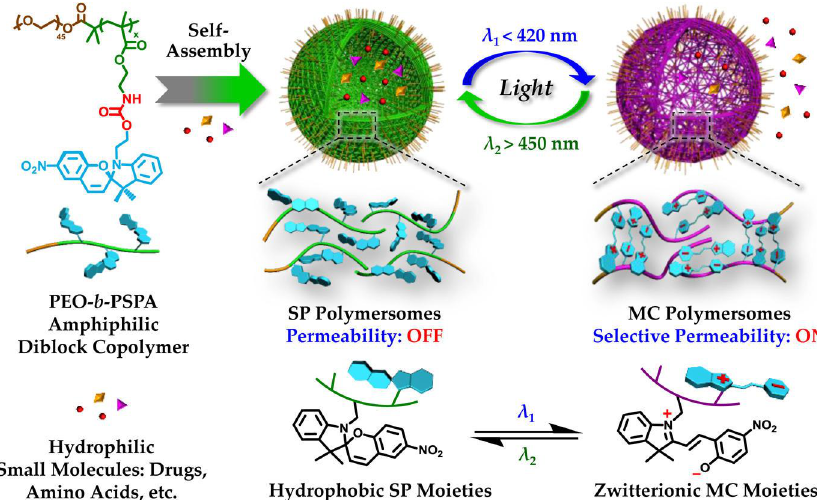
Figure 7. Amphiphilic PEO- b -PSPA diblock copolymers self-assemble into polymersomes with hydrophobic bilayers containing carbamate-based hydrogen-bonding motifs; the spiropyran moieties within the polymersome bilayers undergo reversible photo-triggered isomerization between hydrophobic spiropyran (SP, λ 2 > 450 nm) and zwitterionic merocyanine (MC, λ 1 < 420 nm) states. Reprinted with permission from Ref. [68]. Copyright 2015 American Chemical Society.